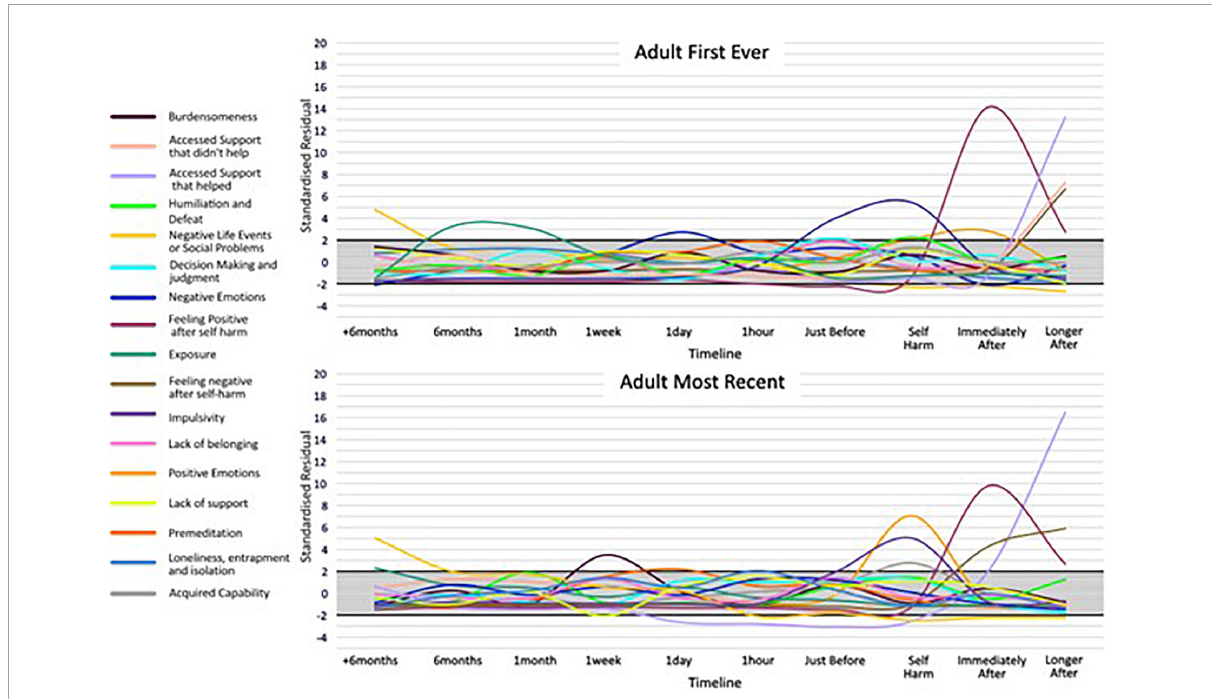
FIGURE4 Indicator Wave graphs showing the temporal organization of categories where at least one time point reached ± 2 for adult first ever and most recent episode of self-harm, SRs ± 2 indicating higher or lower frequency than would be expected by